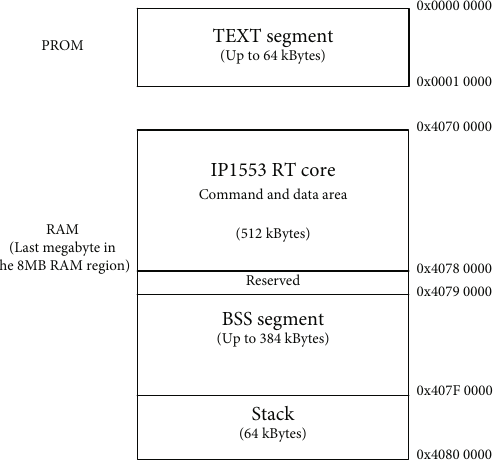
Figure 1: Memory regions assigned to